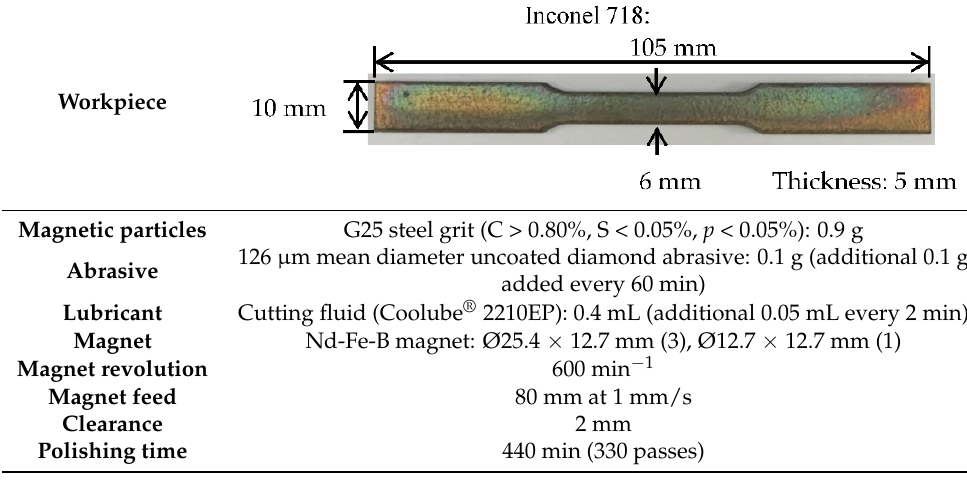
Table 5. The notations of sample and processing conditions.